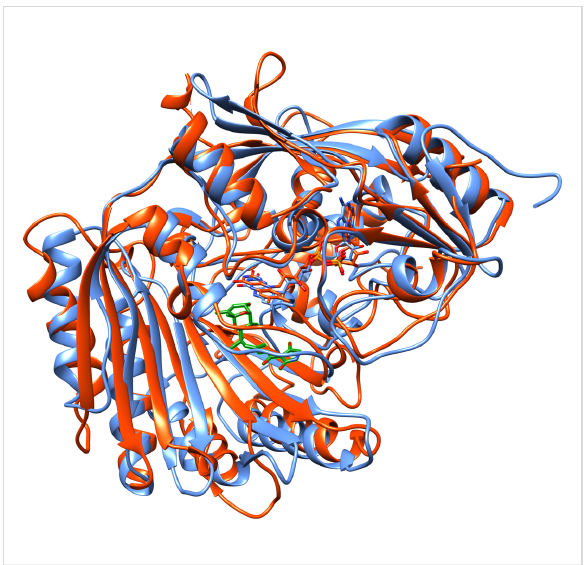
Figure 2: Overlay of the structures of DHNO (blue, pdb file 2bvf) and tirandamycin oxidase (orange, pdb file 2y3s), another member of the p -cresol methylhydroxylase/vanillyl oxidase family. The carbon atoms of tirandamycin are in